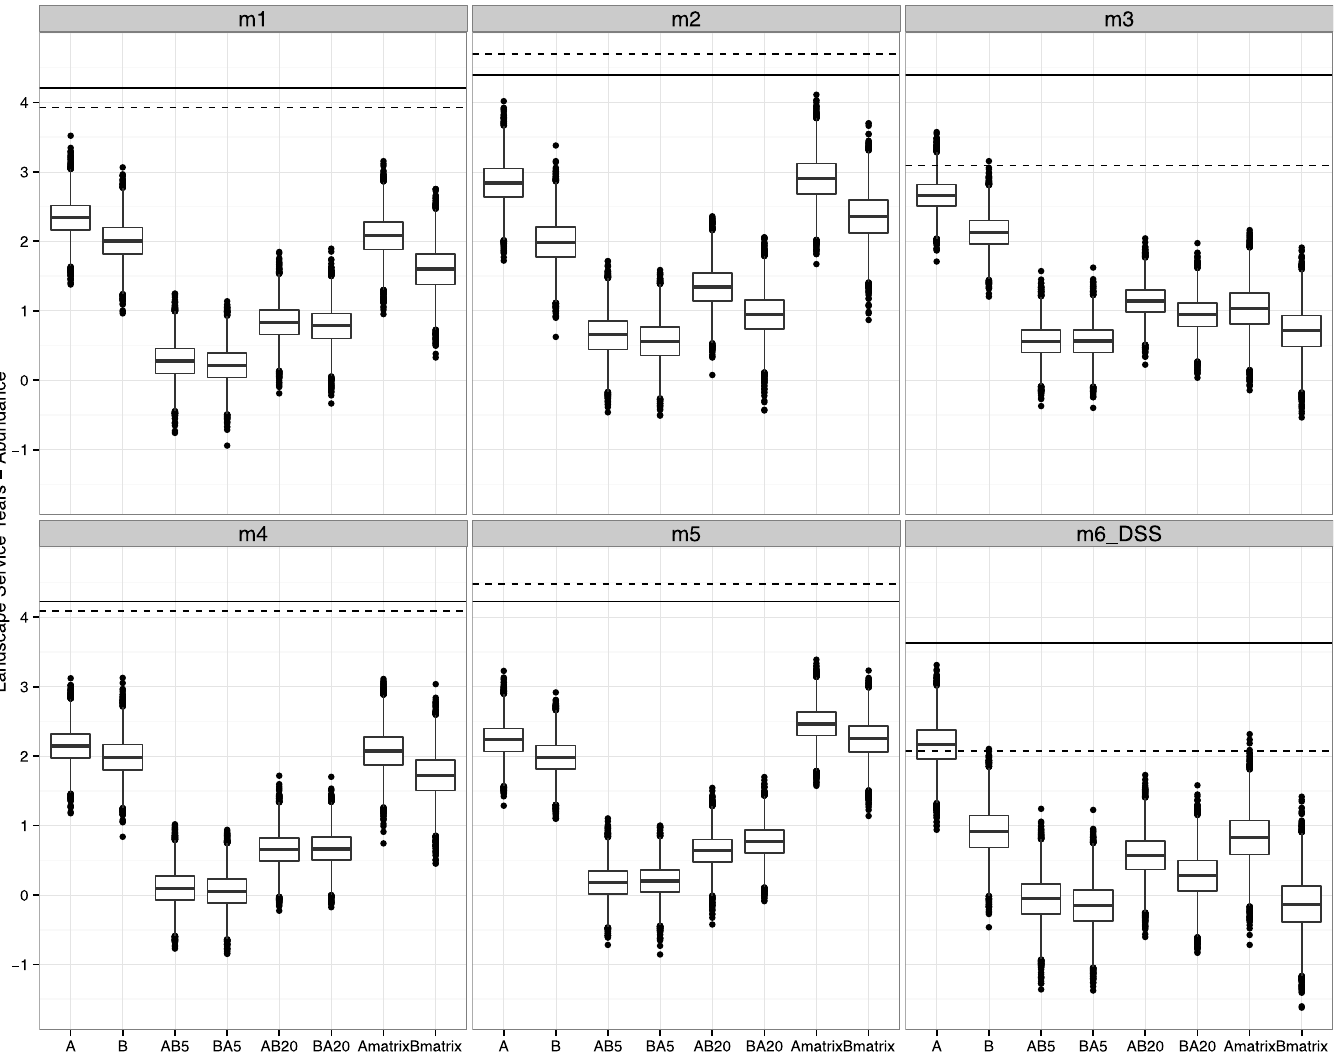
Fig 2. Landscape Service Years for abundance (N). Solid horizontal line represents the number of credits available in the bank, prior to a trade, assuming a static matrix and the dashed horizontal line is the number of credits available under a declining matrix. Boxplots of bootstrapped credit values remaining after each trade, with bars represent median values, the box represents the upper and lower 25 th quartile, whiskers represent max/min values excluding outliers, and dots represent outliers, or values 1.5 x 25 th